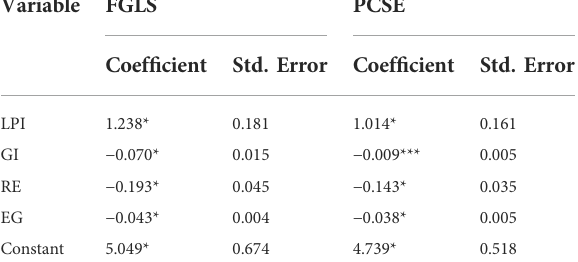
TABLE 7 Robustness